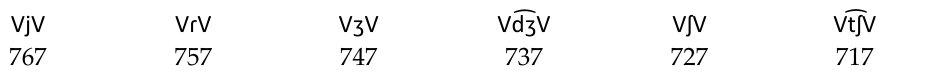
Figure 2. Ranking of [VCV] intensity contours by relative flatness. Flatter contours appear to the left, and greater dips in intensity appear to the right.